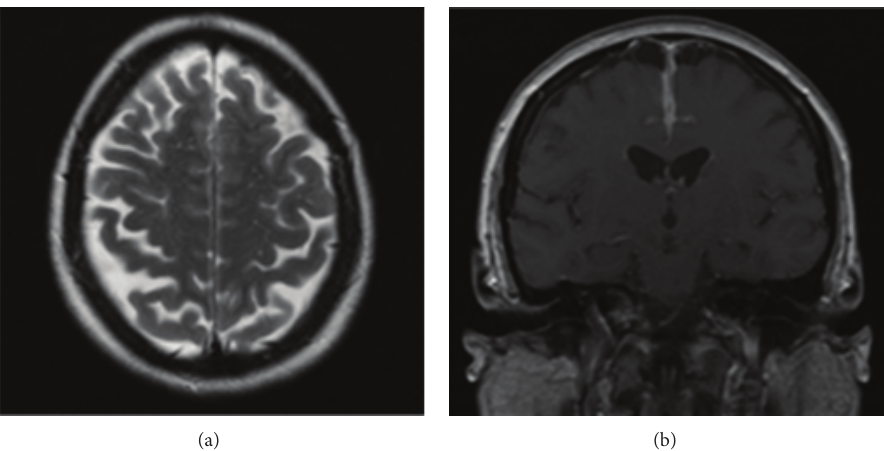
Figure 2: Imaging 5 weeks after presentation, following 3 pulses of methylprednisolone and 2 cycles of IV cyclophosphamide (09/2012). (a) Axial T2 demonstrates substantial resolution of parafalcine oedema. (b) Coronal T1 postcontrast image demonstrates reduction in extent and degree of enhancement in comparison with Figure 1(c).